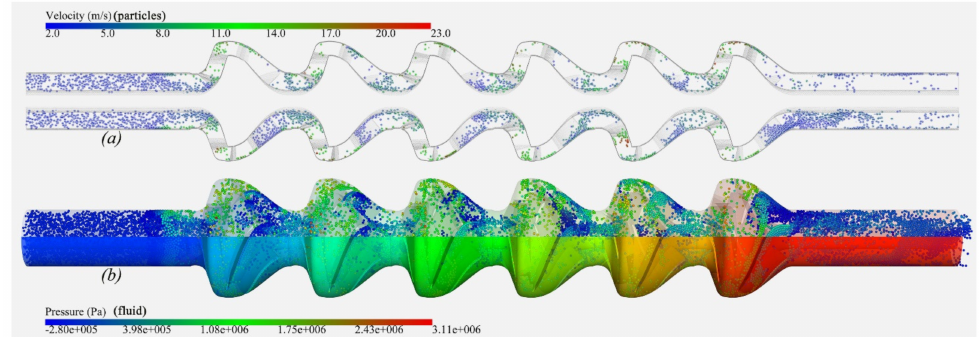
Figure 11. Slurry simulation of a six-stage pump at a rated flow rate and 1450 rpm: ( a ) central axis slice of particle distribution; ( b ) composite diagram of static pressure and particle distribution.